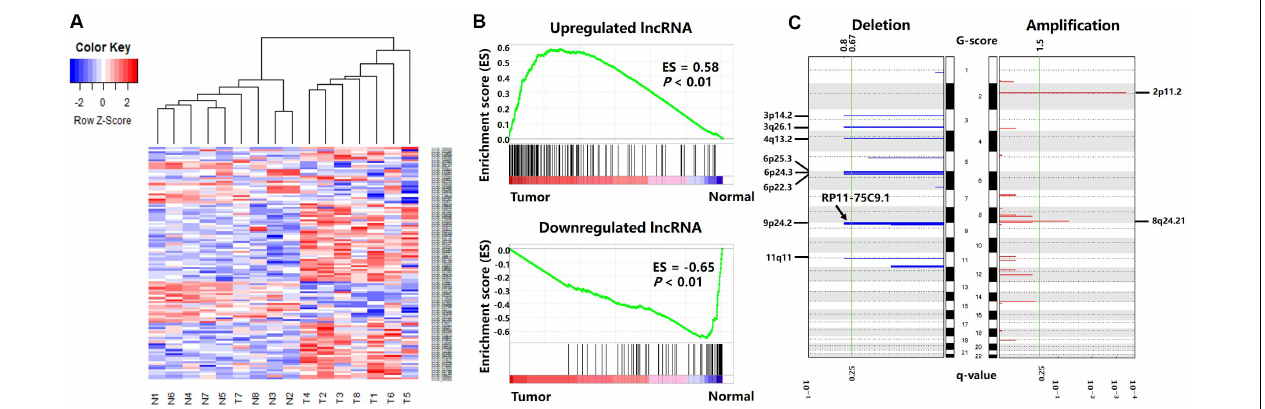
FIGURE 3 | Differentially expressed lncRNAs between cancer and normal tissues. (A) Differentially expressed lncRNA clustering analysis. Rows are lncRNAs, and columns are samples. Blue denotes downregulation in gastric cancer and red denotes upregulation in gastric cancer. (B) GSEA enrichment analysis results. (C) Deletions and amplifications in gastric cancer genomes.